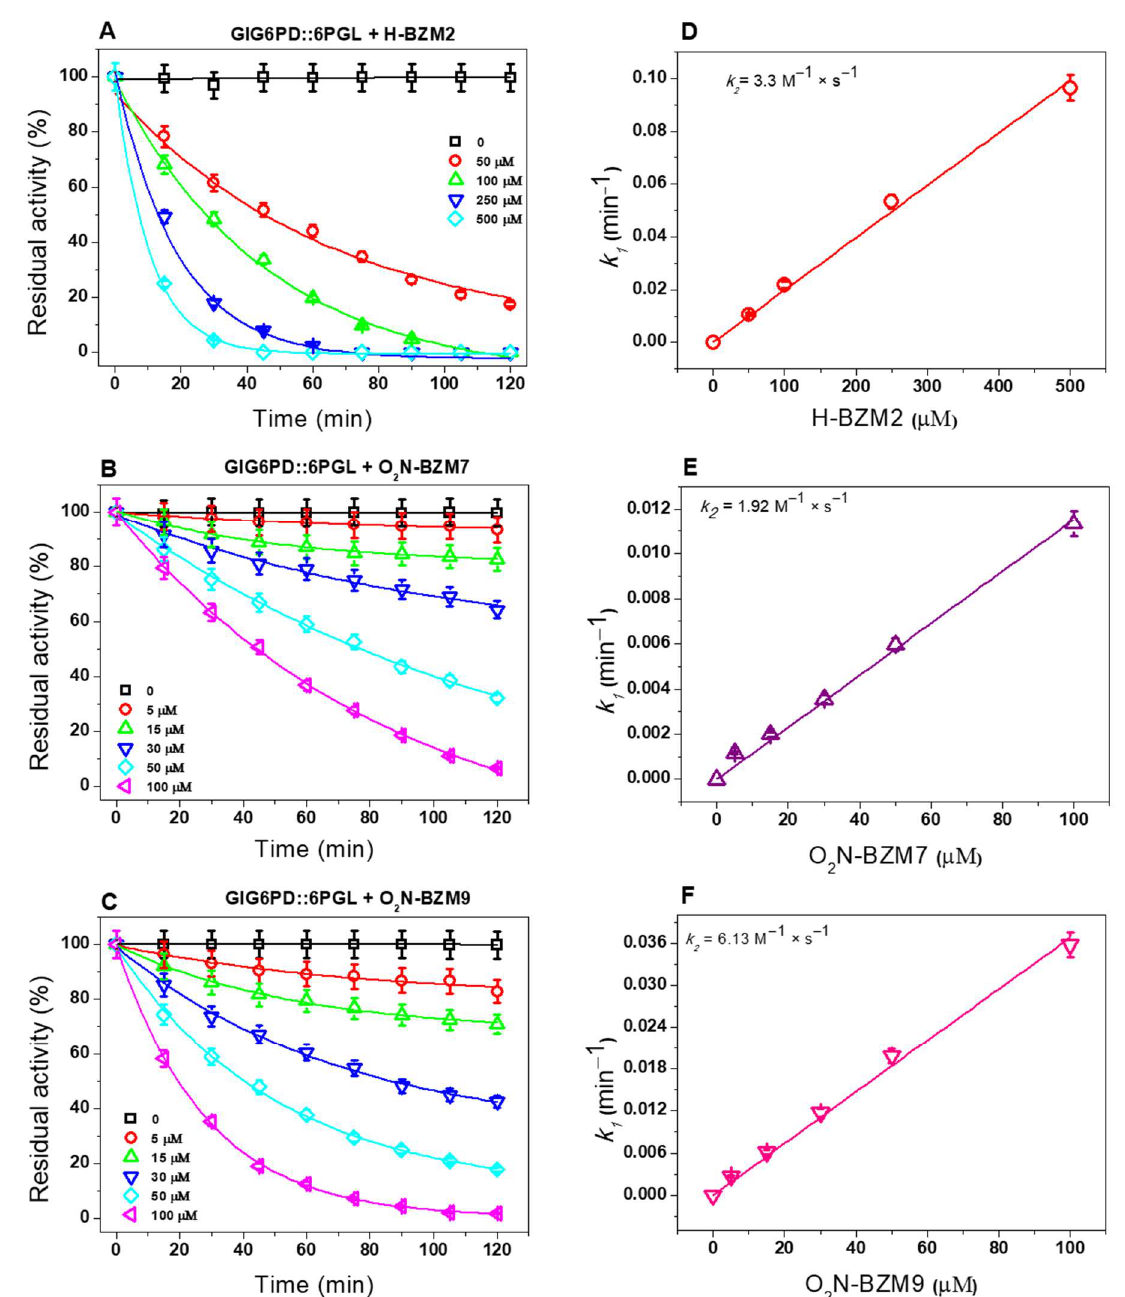
Figure 3. Inactivation assays of G6PD::6PGL enzyme form G. lamblia with H-BZM2 , O 2 N-BZM7 , and O 2 N-BZM9 . ( A – C ) Pseudo-first-order rate constants ( k 1 ) for each compound were calculated by fitting the data to the exponential decay equation A R = A 0 e −kt , where A 0 is the initial activity value. All the experiments were performed in triplicate; the bars represent the standard error. ( D – F ) Second-order inactivation rate constants ( k 2 ) were obtained by plotting k 1 values against compound concentrations and fitted to a linear regression model. All experiments were performed in triplicate; standard errors were less than 5%.